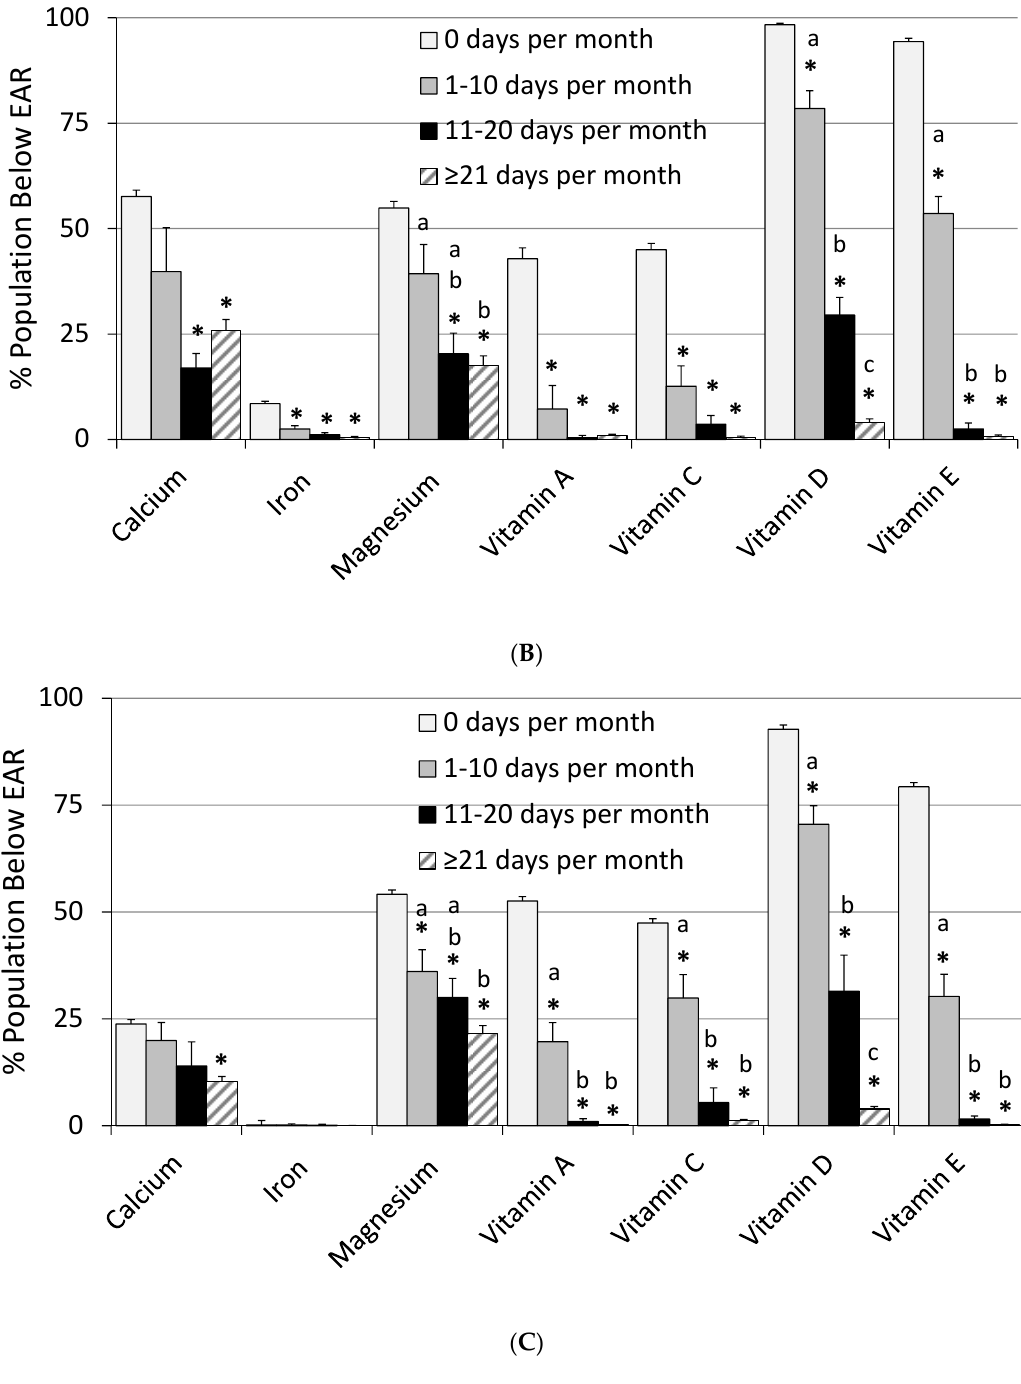
Figure 3. Prevalence of inadequacy (% of population below EAR) of “underconsumed nutrients” identified in 2015–2020 Dietary Guidelines for Americans for food + MVMS by frequency of MVMS intake among all adults ( A ); females ( B ); and males ( C ) age 19 years and older. NHANES 2009–2012. * Significantly different from 0 days per month at p < 0.01. a,b,c Values by frequency of MVMS with different superscripts are significantly different at p < 0.01. EAR: estimated average requirement; MVMS: multi-vitamin/multi-mineral supplements; NHANES: National Health and Nutrition Examination Survey.